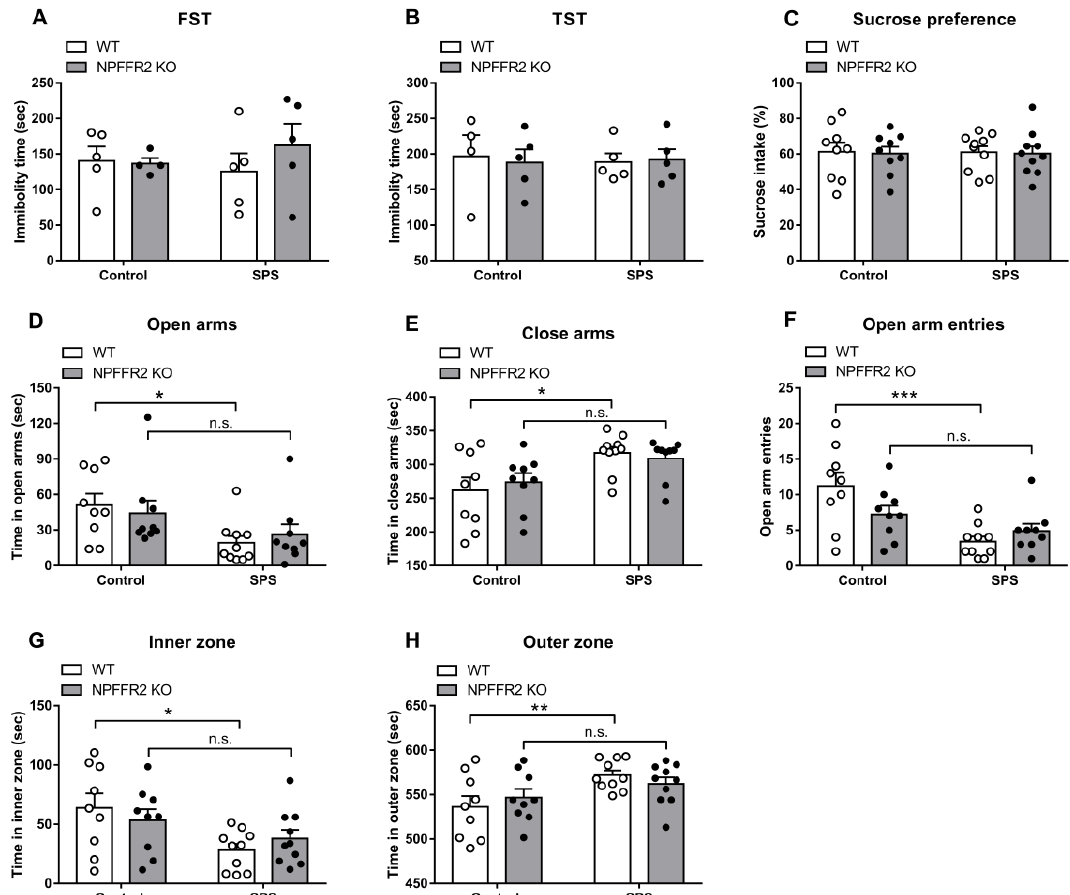
Figure 3. Behavioral changes in WT and NPFFR2 KO mice after SPS. Depressive- and anxiety-like behaviors were recorded for WT and NPFFR2 KO mice exposed to SPS. Depressive-like behaviors were measured by ( A ) forced swimming test (FST), ( B ) tail suspension test (TST), and ( C ) sucrose preference test. Anxiety-like behaviors were measured by elevated plus maze (EPM) and open field test (OFT). In the EPM, the durations mice spent in open arms ( D ) and closed arms ( E ), and open arm entries ( F ) were calculated. In the OFT, the durations mice spent in the inner zone ( G ) and outer zone ( H ) were calculated. Data are represented as mean ± SEM and are analyzed by two-way ANOVA with Bonferroni’s multiple comparison test. * p < 0.05, ** p < 0.01, *** p < 0.001, n.s., no significance; comparing control and SPS groups. FST and TST, n = 4–5 per group; all other tests, n = 8–10 per group. The white and black dots indicate the individual value of WT and NPFFR2 KO mice, respectively. EMP result of one NPFFR2 KO mouse exposed to SPS was excluded because the mouse was fallen from an open arm platform during the test.